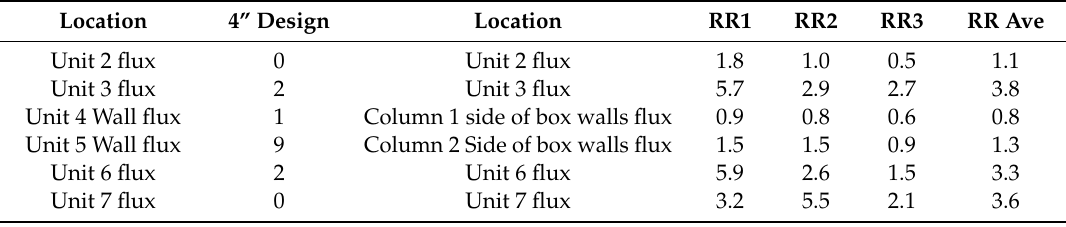
Table 6. Wall deposition fluxes (g/m 2 /h) for an 8.8 wt% solids concentration feed at an inlet air temperature of 170 °C (RR1 = repeated run 1, RR2 = repeated run 2, RR3 = repeated run 3), comparing the existing (previous) four-inch design with the results from the new box design; no air leakage.